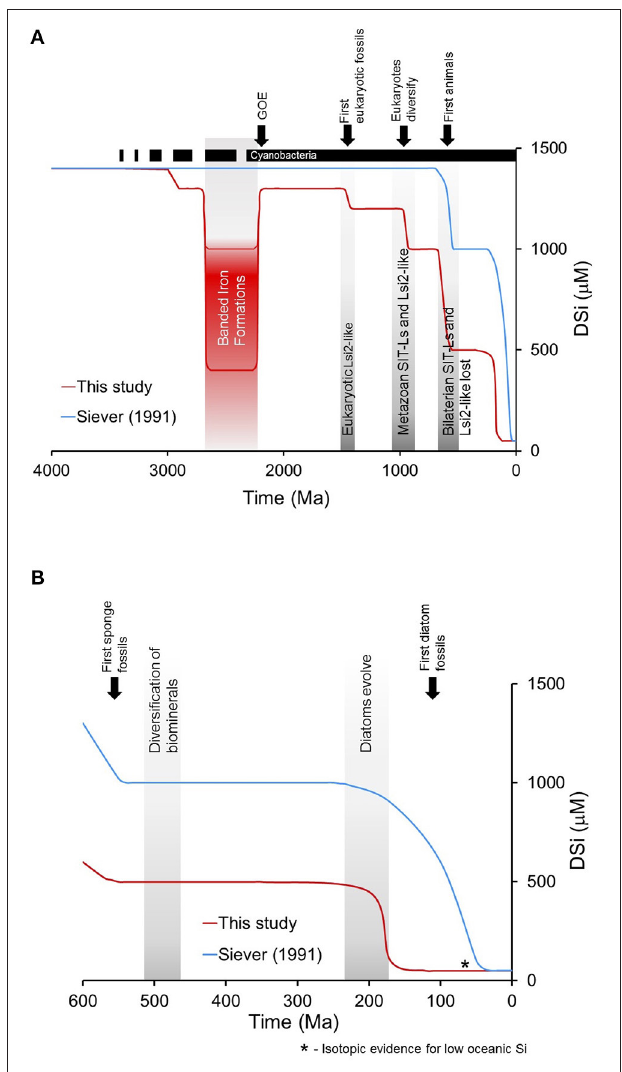
FIGURE 5 | The evolution of the oceanic Si cycle through geologic time envisioned by Siever (1991) (blue line) together with our narrative for reductions in DSi primarily through biosilicification (red line). (A) From the early Precambrian to the present with the major biological and geological events. The dotted line for cyanobacteria reflects the uncertainty in the timing of its evolution in the geological record. (B) DSi from the latest Precambrian to the